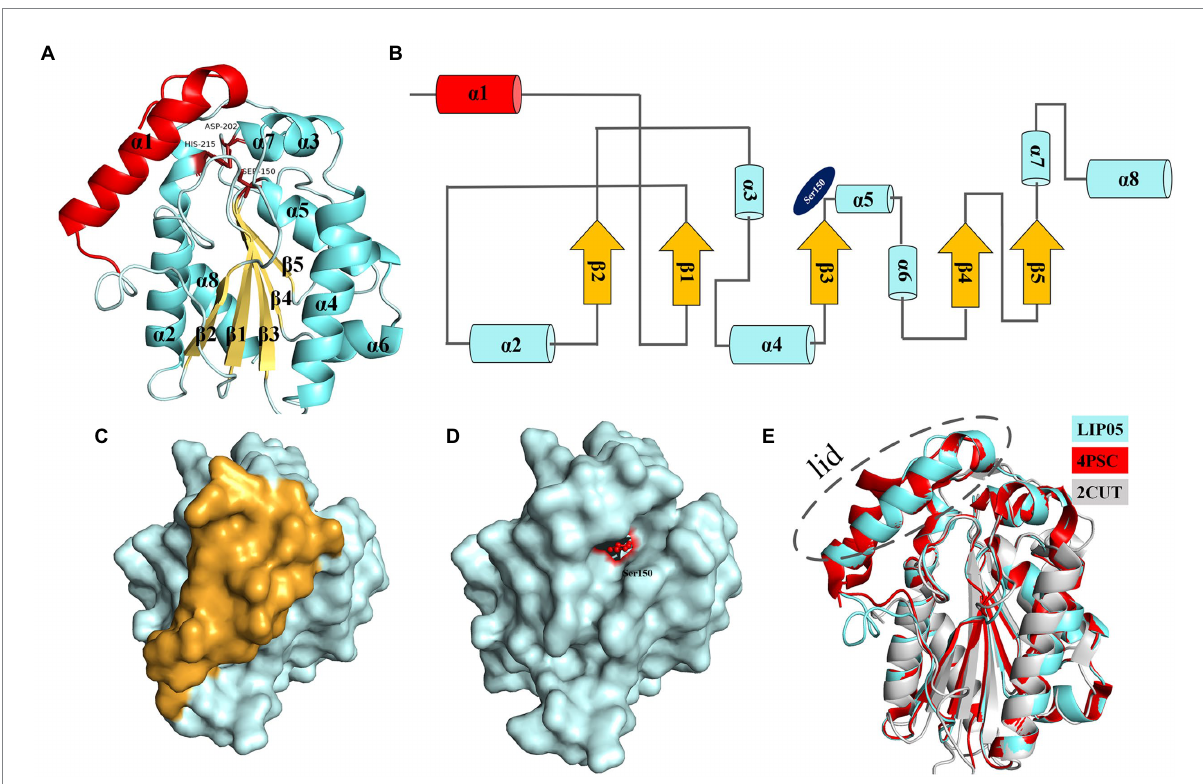
FIGURE 1 Structure analysis of LIP05. (A) Homologous modeling of LIP05. (B) Topological structure of LIP05. (C) Surface model of LIP05, and yellow color domain was the lid domain. (D) Lid domain removed of LIP05, and red color domain was Ser150. (E) Structural comparison of LIP05 with enzymes 4PSC and